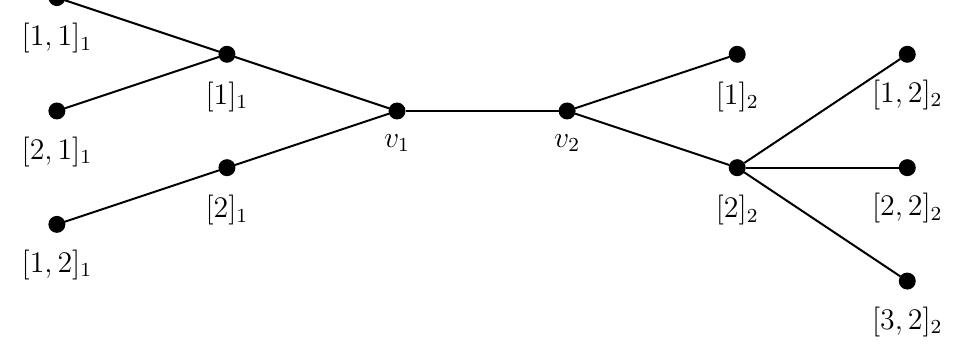
Figure 1: Labelling vertices in T